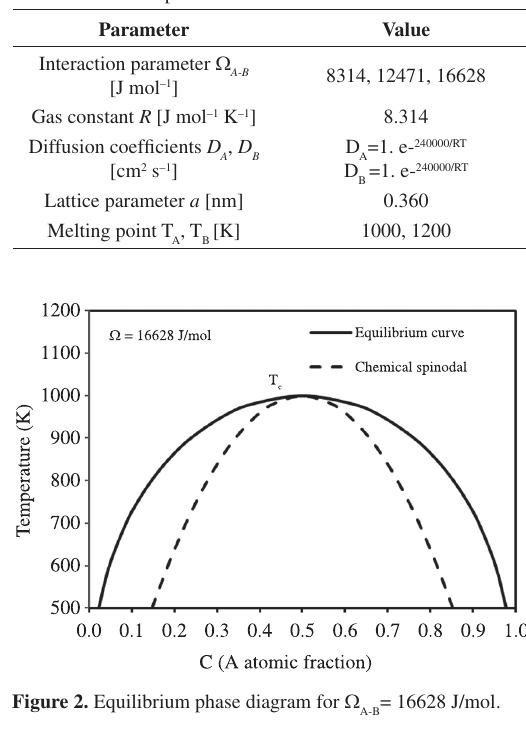
Figure 2. Equilibrium phase diagram for Ω